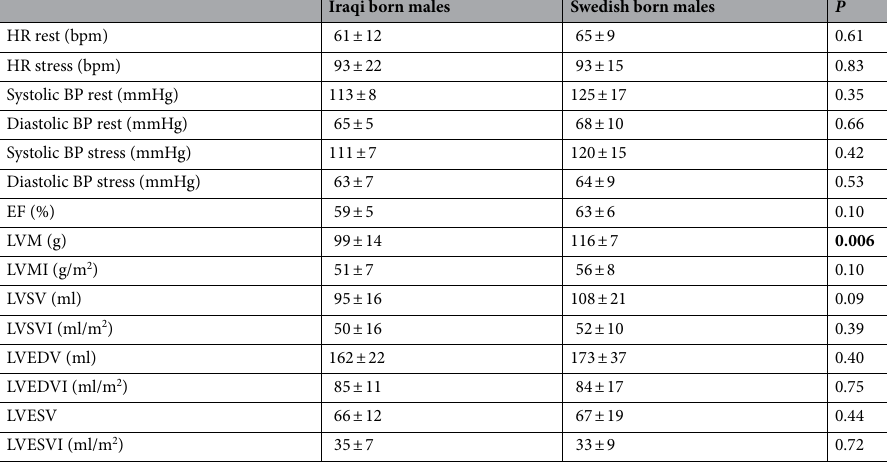
Table 2. Hemodynamic and cardiovascular magnetic resonance imaging characteristics. HR heart rate, BP blood pressure, EF ejection fraction, LVM left ventricular mass, LVMI left ventricular mass indexed, LVSV left ventricular stroke volume, LVSVI left ventricular stroke volume indexed, LVEDV left ventricular end-diastolic volume, LVEDVI left ventricular end-diastolic volume indexed, LVESV left ventricular end-diastolic volume, LVESVI left ventricular end-diastolic volume indexed. Significant values are given in bold.